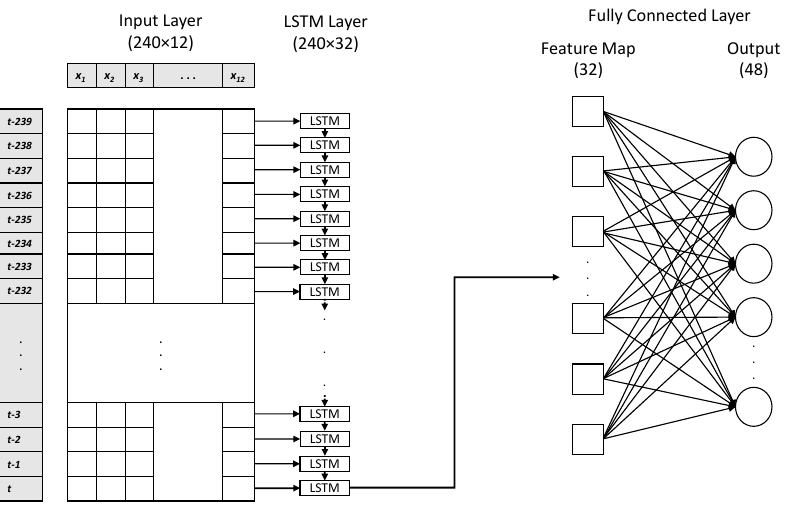
Figure 5. Baseline LSTM